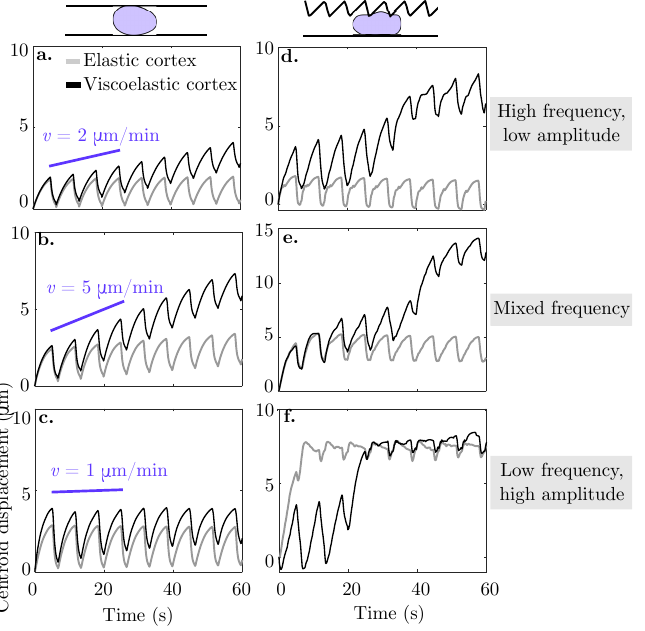
Figure 6. Cortical turnover enables cell motion in a variety of rigid confined environments. The curves represent the horizontal displacement of the cell centroid over time in a confined environment. In panels ( a – c ), the cell in placed in a rigid straight micro-channel of width 18, 13, and 9 µ m, respectively. Panels ( d – f ) show the horizontal displacement of the cell centroid over time for a cell placed in a asymmetric rigid channel with a straight bottom wall and a: ( d ) high frequency, low amplitude, ( e ) mixed frequency, and ( f ) low frequency, high amplitude sawtooth top wall. Across all panels, bleb neck size is 16 µ m. The light grey curve represents the data for an elastic membrane and cortex, while the black curve denotes a viscoelastic cortex with strain relaxation timescale λ = 30